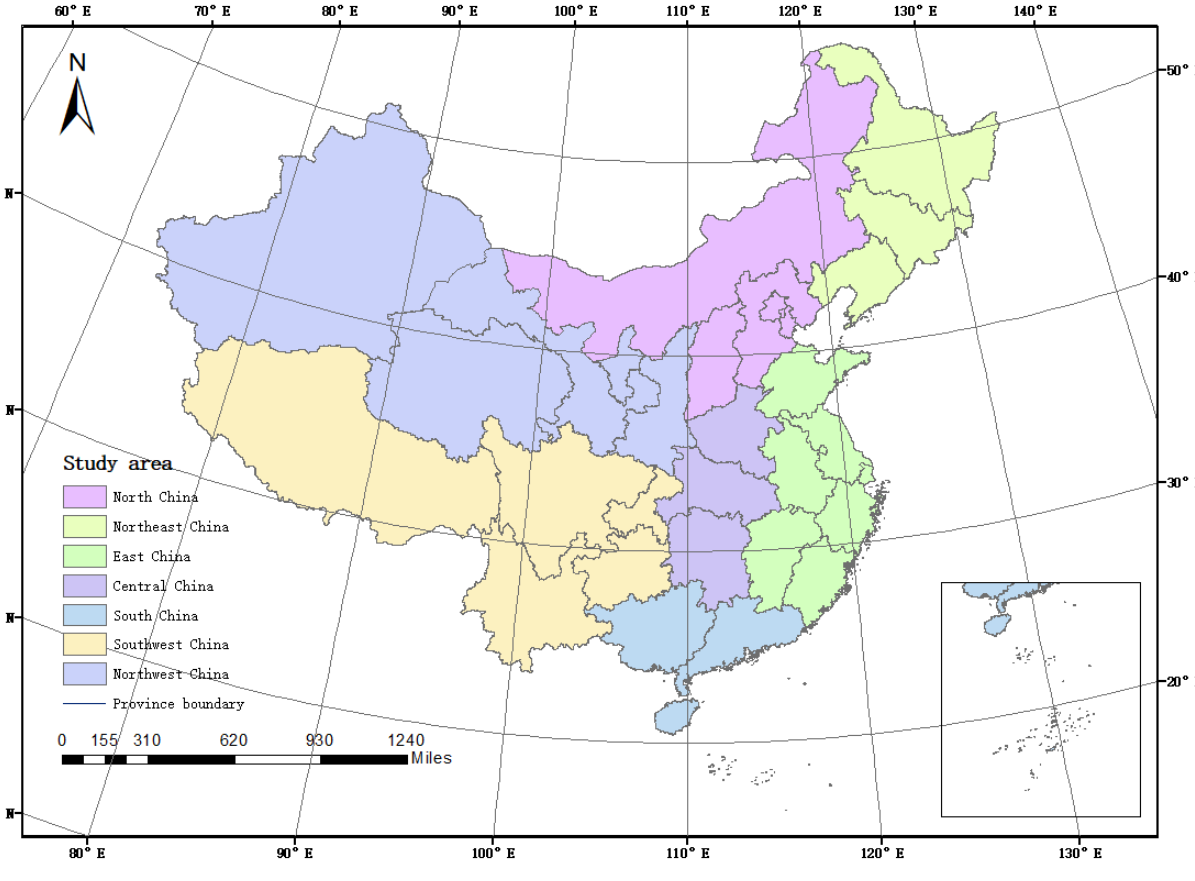
Figure 1. The study area.